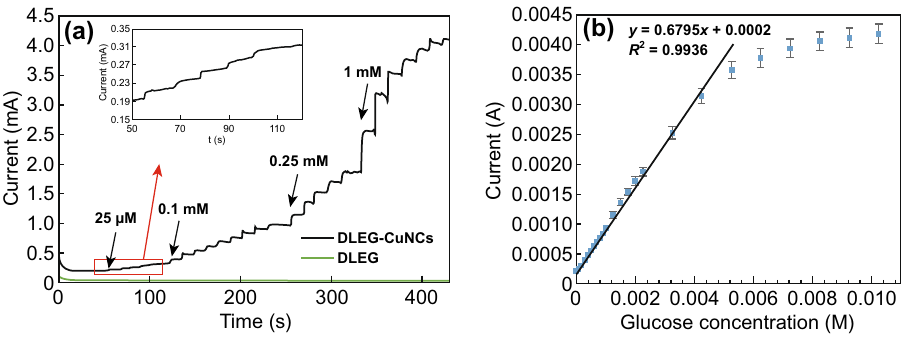
Fig. 5 a Amperometric current response with successive addition of different glucose concentrations. b Calibration curve of the glucose sensor. a , b Adapted with the permission from Ref. [62], Copyright 2016 Springer